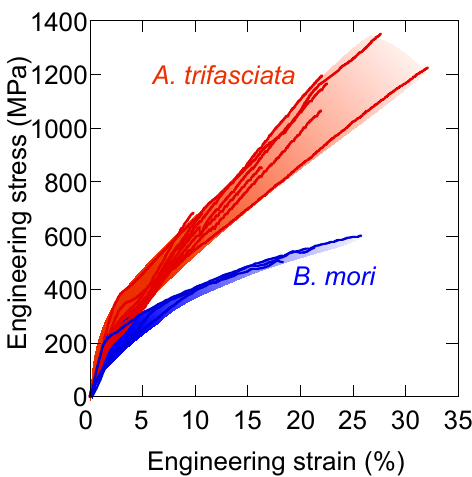
Figure 3. Stress vs. strain curves of forcibly silked native dragline silk fibers from A. trifasciata (in red) and silk fibers from B. mori (in blue). Original data from [88,89].